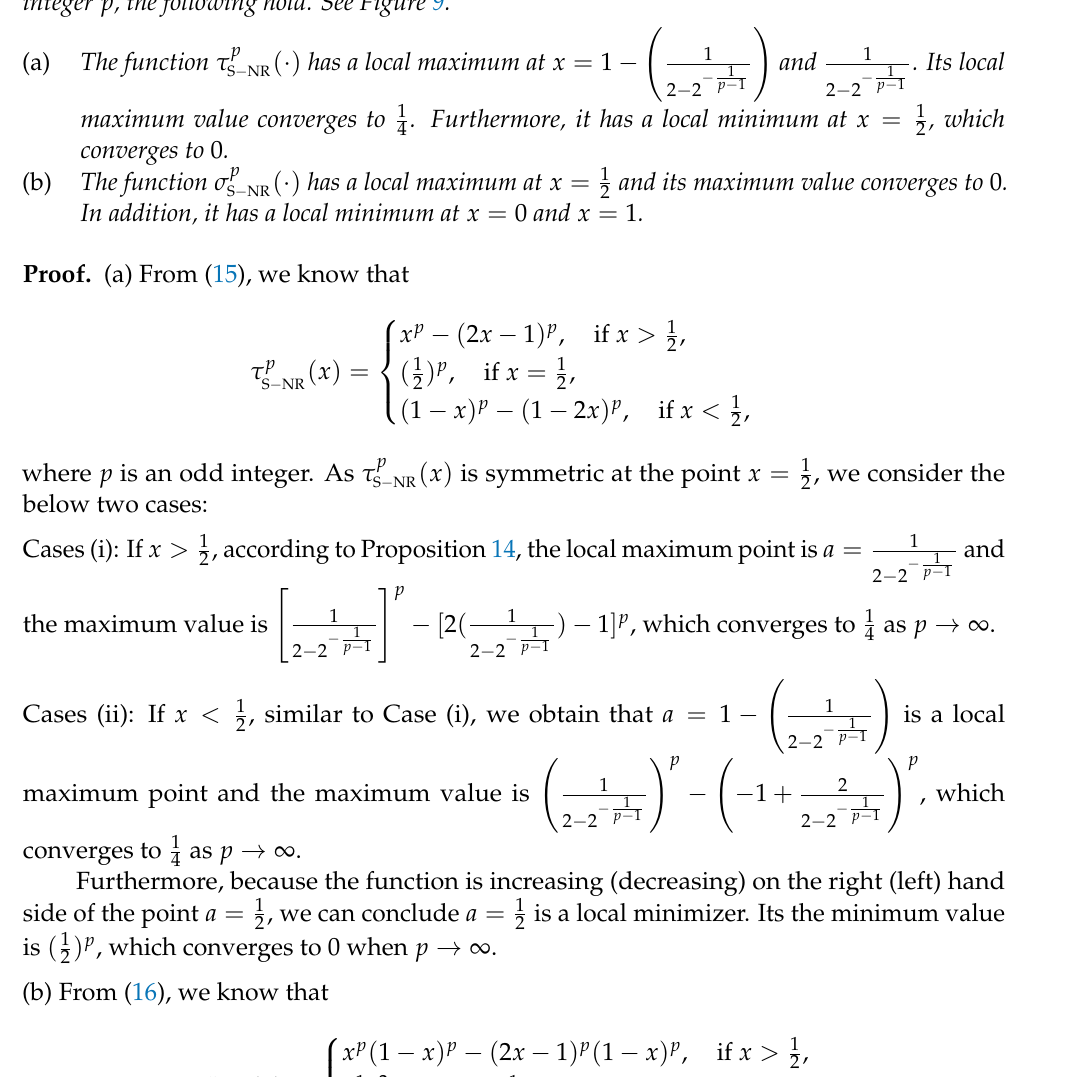
( x ) with different values of p NR